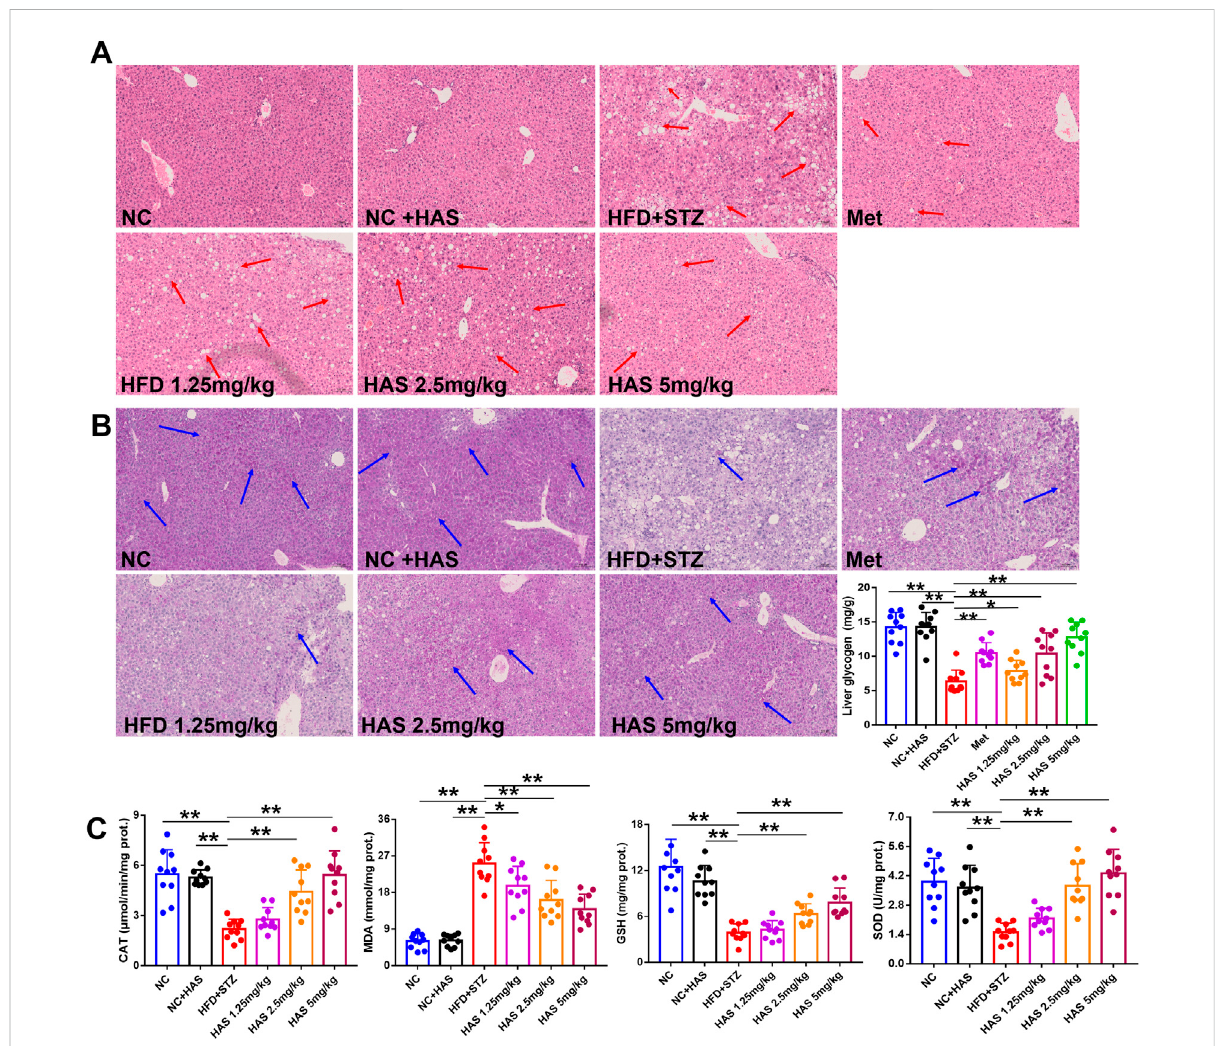
FIGURE 3 Effects of HAS on histopathology, oxidative stress, and liver glycogen of T2DM mice. Liver sections were stained with HE (A) and PAS (B) to determine the histopathological changes and liver glycogen content, respectively, in HFD + STZ mice. (C) Effects of HAS on oxidative stress in liver tissuesofT2DMmice.Thedosesof2.5,5.0,and10 mg/kgindicatelow,middle,andhighdosesofHAS,andthedoseofMetwas150 mg/kg.Dataare expressed as mean ± SD ( n = 10), ** p < 0.01 vs. HFD + STZ